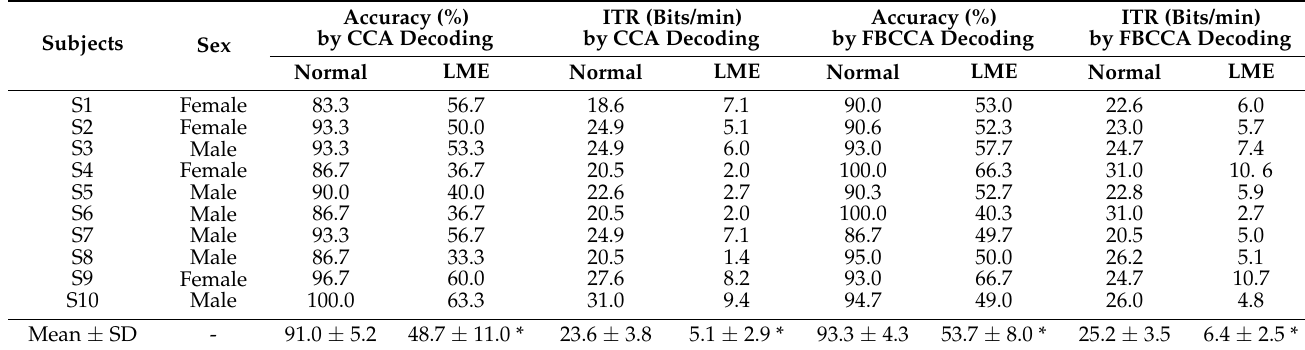
Figure 5. Evoked P300 signals and SSVEP signals.